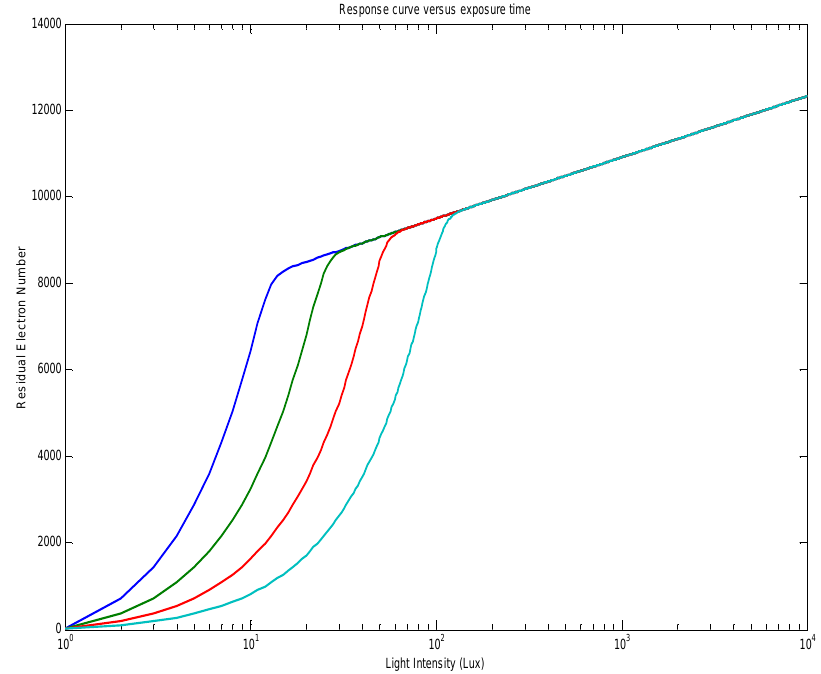
Figure 5. The response curve as a function of different exposure times. Here the buried photodiode parameters are the same as those in Figure 2; the exposure times are set at 40 ms, 20 ms, 10 ms, and 5 ms, respectively (in order from left to right).